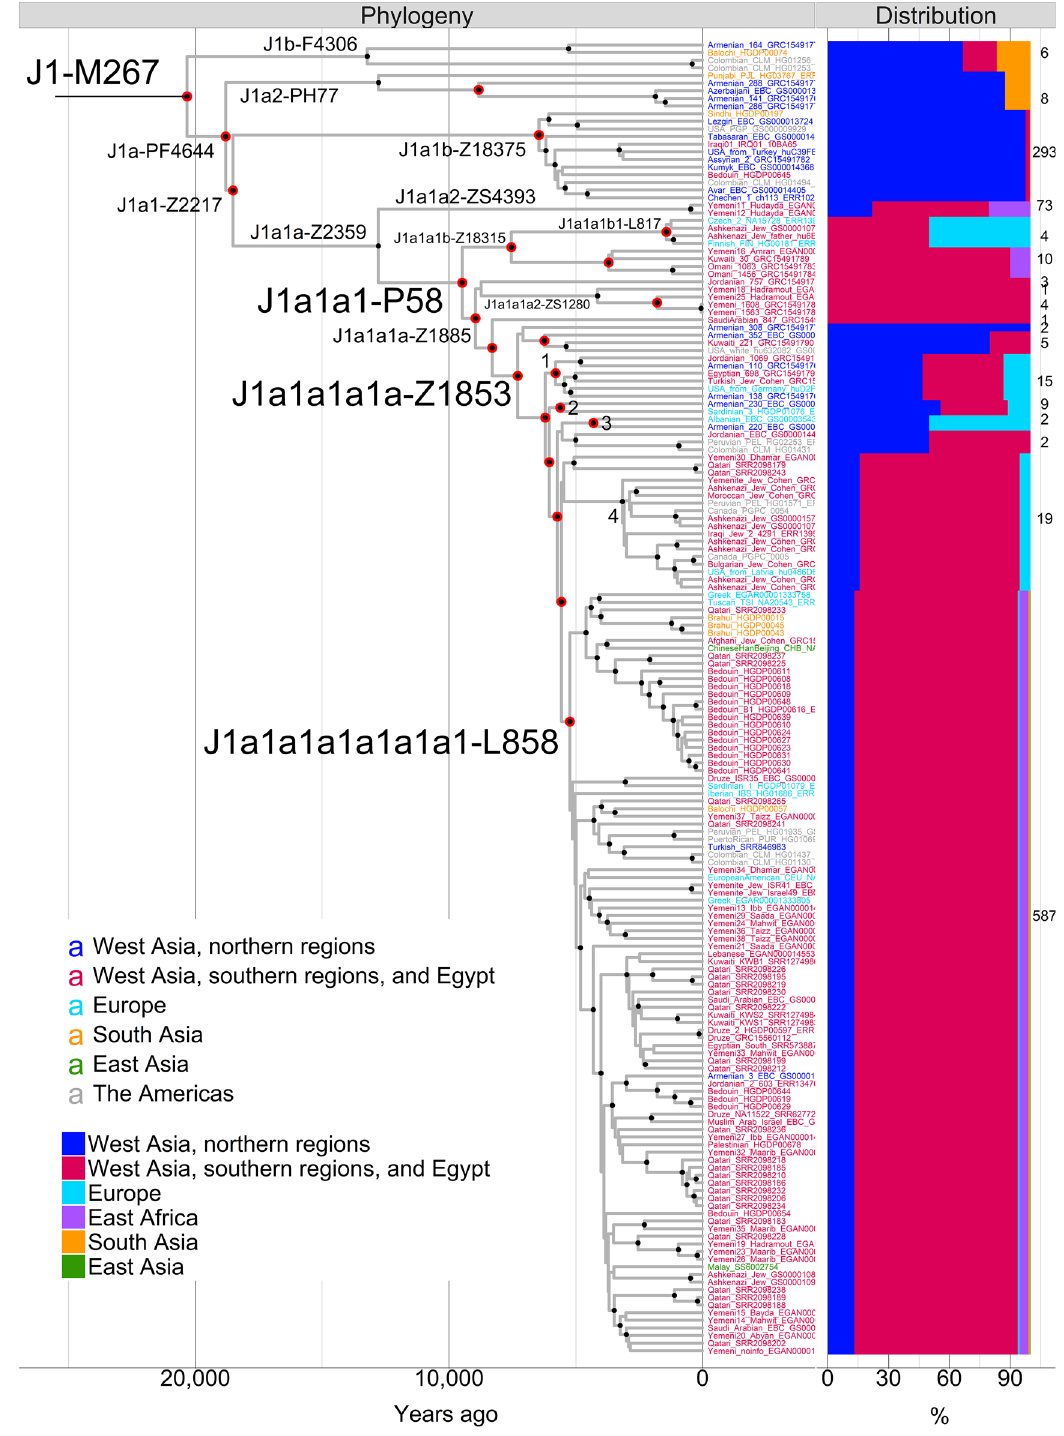
Figure 2. Bayesian time-scaled maximum clade credibility tree of haplogroup J1-M267 and the distribution of the genotyped branches. The phylogeny is reconstructed with Beast v1.10.4 software 82 . Black filled circles mark the nodes with posterior probability ≥ 0.95. Red filled circles mark the nodes genotyped in the genotyping dataset. Tip labels are color coded according to geography. The frequencies of the branches are calculated out of 158 sequenced and 889 genotyped Eurasian and African samples belonging to that branch. The overall numbers are denoted at the rightmost side of the plot. The numbers written at the tree nodes refer to the following branches: 1—J1a1a1a1a1b-Z18297, 2—J1a1a1a1a1a2-ZS2524, 3—J1a1a1a1a1a1b-B2069, 4—